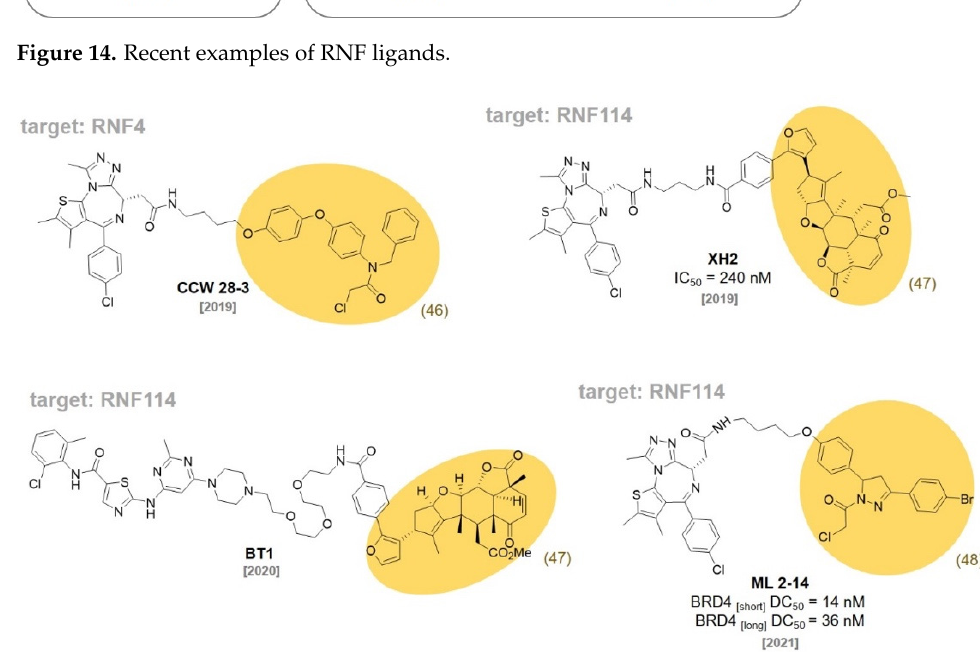
Figure 15. RNF ligand-based PROTACs targeting RNF4 and RNF114.